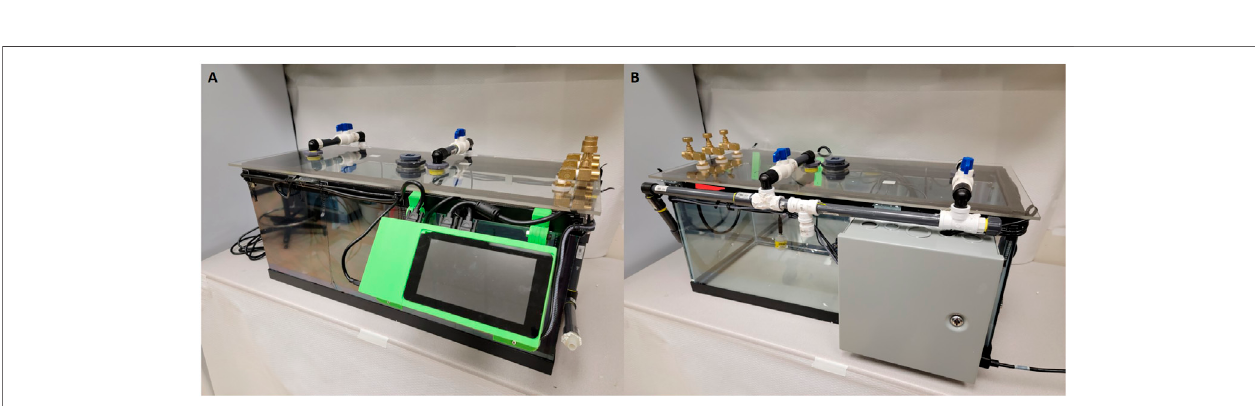
FIGURE 2 | Images of current cage design including updated sensors and revised power supply. (A) Front view of the chamber with a 7 inch Raspberry Pi touch screen and visible air fl ow systems. (B) Rear view of the chamber with power supply container and air fl ow input tubes visible.